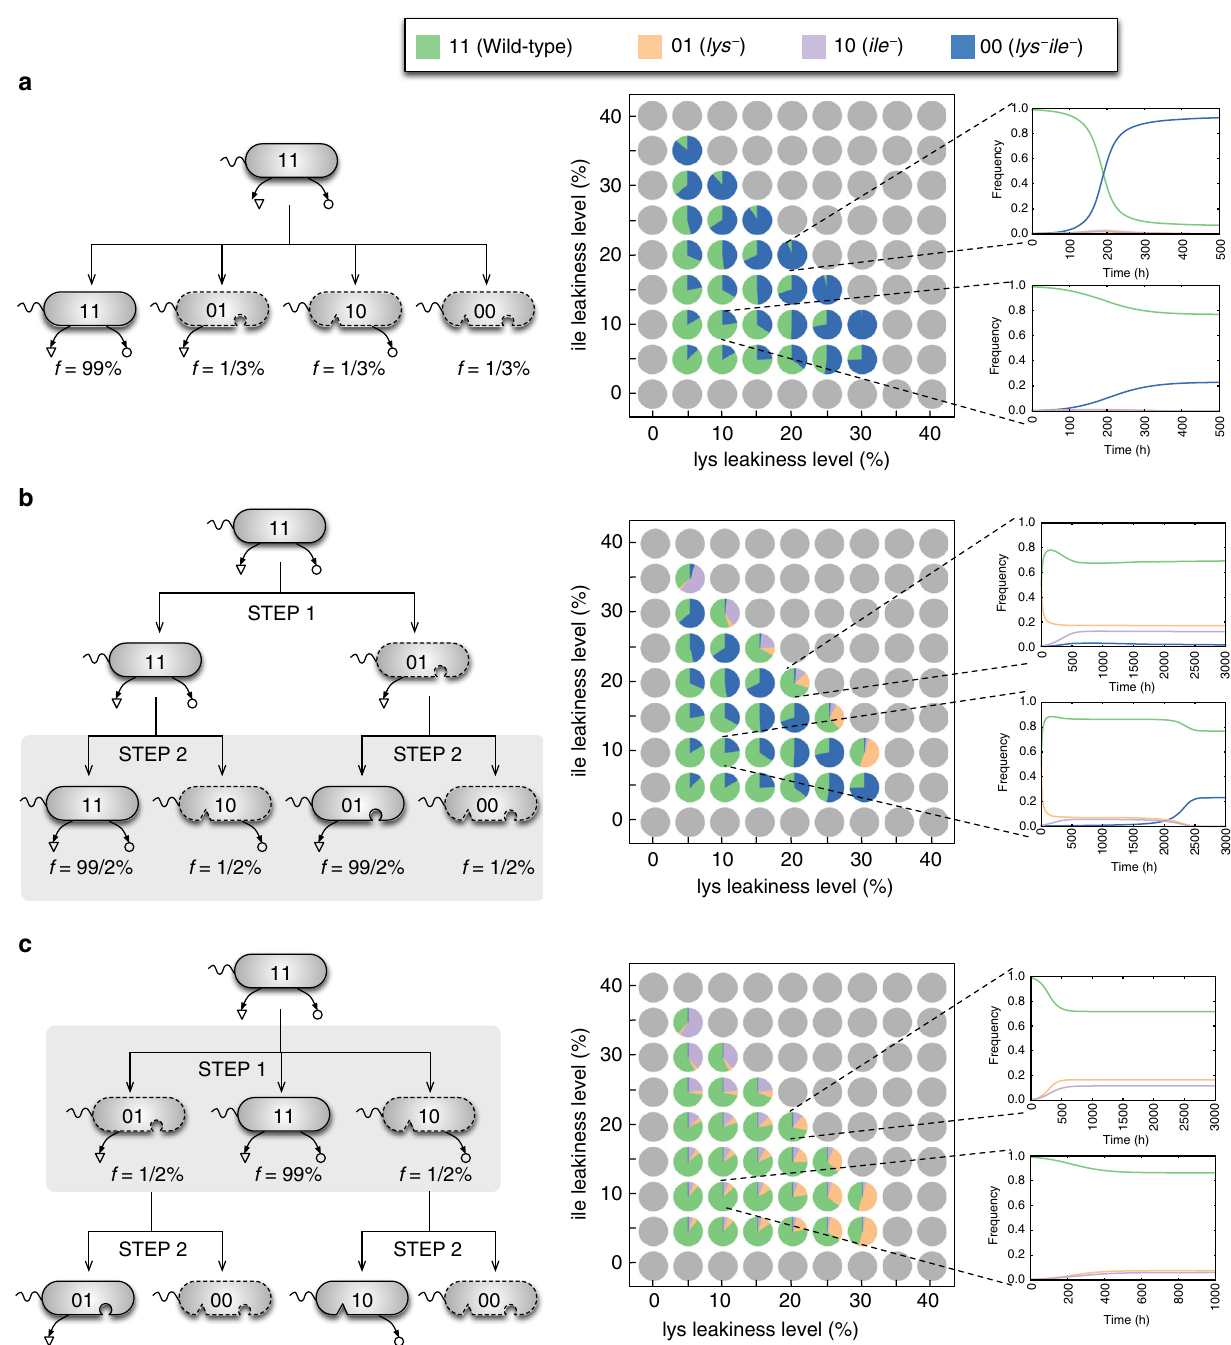
Fig. 6 Impact of the initial genotype frequencies on the evolutionary emergence of metabolic dependencies in populations of E . coli with two leaky amino acids. Here, we have shown the results of targeted in silico invasion experiments for a representative amino acid pair (lysine and isoleucine) (see also Fig. 4c). a 00, 01, and 10 simultaneously originate from 11 (i.e., WT) through genome streamlining and invade an existing population of 11 genotypes. b A small population of 10 and 00 invade a resident population of the 11 and 01. This simulates the second step of a two-step process for the loss of the leaky functions hypothesized in ref. 10 (see the main text for details and also Supplementary Fig. 8). c A small population of 01 and 10 invades a resident population of 11. This models an alternative scenario for the two-step loss of leaky functions leading to stable cross-feeders: Two partial producer mutant genotypes (01 and 10) simultaneously originate from 11, followed by the rise of the 00 genotype from 01 and/or 10 in a later stage. As shown here, cross- feeders can evolutionarily stabilize and coexist with 11 genotypes in the fi rst step. Further analysis showed that cross-feeders are also resistant to invasion by 00 genotypes arising in the second step (see Supplementary Fig. 9). Dynamic plots in a – c show the sample evolutionary dynamics of the system for selected equal leakiness levels for both lysine and isoleucine. Pie charts show the equilibrium frequencies of each genotype starting from the initial genotype frequencies shown in each panel. These equilibrium frequencies are given only for the sustainable leakiness region (green region in Fig.